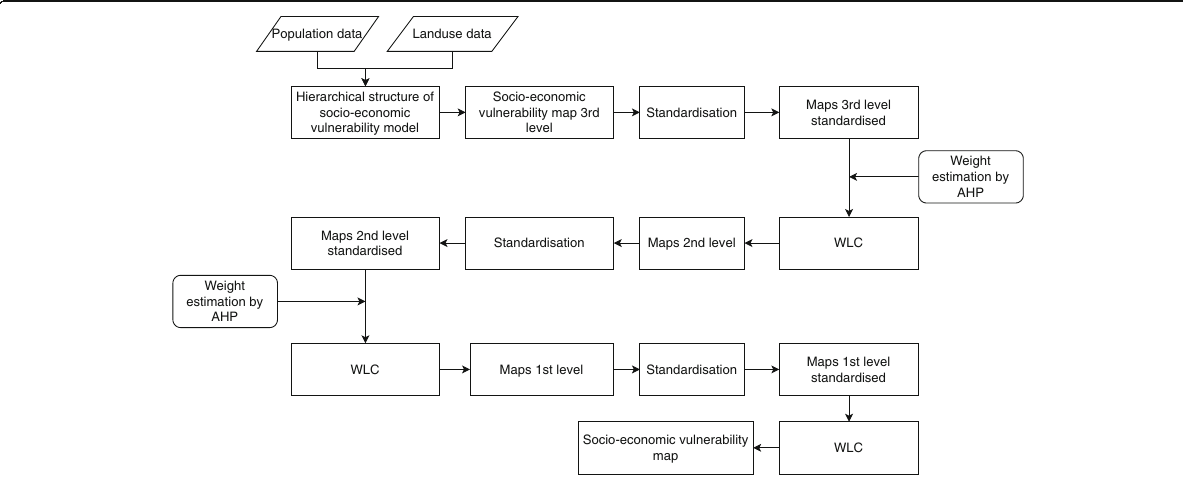
Fig. 2 Methodology for Socio-economic vulnerability